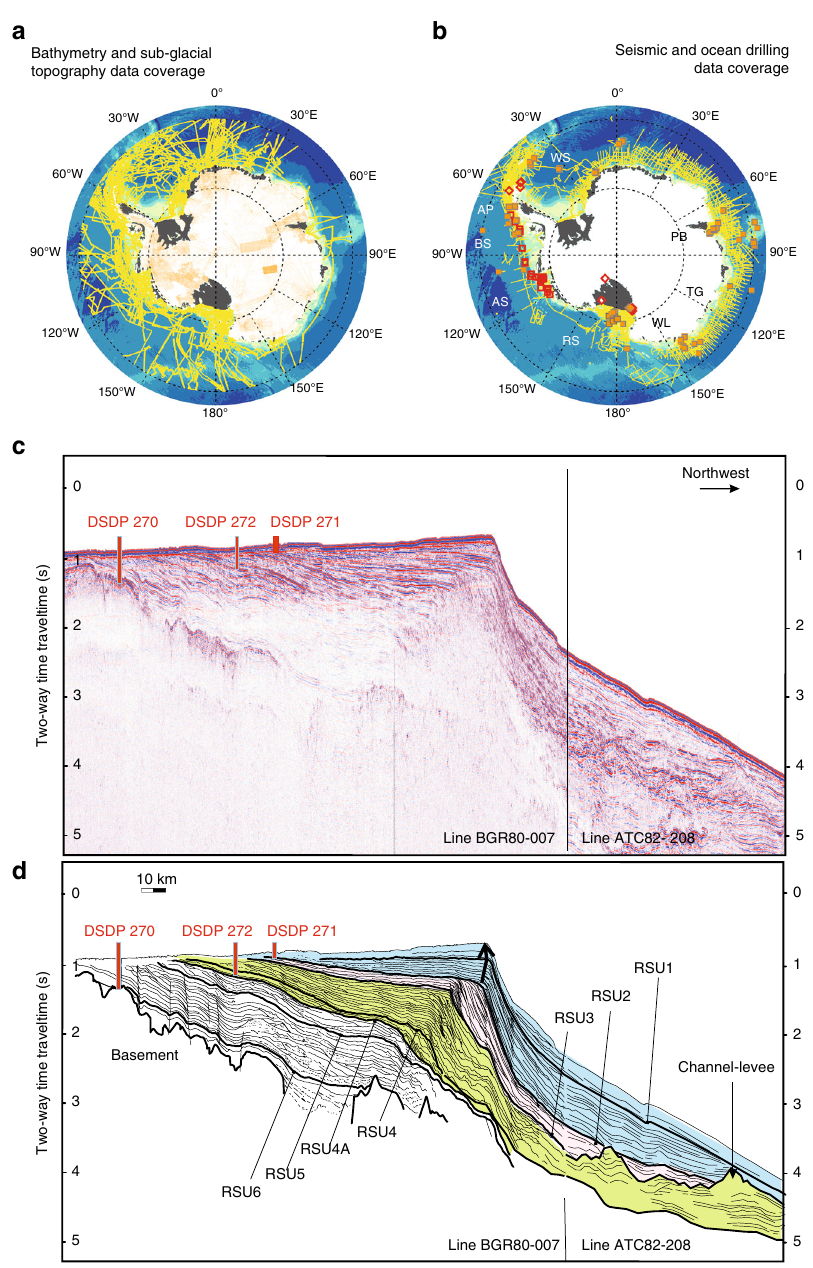
Fig. 3 Present and past knowledge of continental margins morphology. a Bathymetric (yellow) and subglacial topography (orange) data coverage used to reconstruct the BEDMAP2 subglacial topographic dataset 34 including the bathymetry around the margins from the IBCSO dataset 56 (here, multibeam coverage only). b Seismic data coverage (yellow, Antarctic Seismic Data Library System, https://sdls.ogs.trieste.it) from Antarctic Peninsula (AP), Amundsen Sea (AS), Bellingshausen Sea (BS), Ross Sea (RS), Weddell Sea (WS), Wilkes Land (WL), Prydz Bay (PB) and Sabrina Coast-Totten Glacier (TG) continental margins. Existing (yellow squares) or short-term scheduled (red) Ocean Drilling Program/International Ocean Discrovery Program drilling sites (https://iodp.tamu.edu/scienceops/maps.html) used to constrain and restore past continental margins morphology. White or gray areas indicate little or no data coverage. c Multichannel seismic pro fi les BRG80-007 and ATC82-208 in the Ross Sea with existing deep drill site locations (projected) from Deep Sea Drilling Program Leg 28 116 . d Line drawing 52 showing the horizons from the Oligocene-early Miocene Ross Sea Unconformity RSU6 to the Pleistocene RSU1 across the eastern Ross Sea. Progradation of the continental shelf margin occurred from RSU4A to RSU3 (early-late Miocene, 19-10 Ma 51,52 ), along with channel-levee complexes formation in the deeper areas (green shade). During the next phase between RSU3 and RSU2 (late Miocene- early Pliocene, 10 – 4 Ma 51,52 ), trough-mouth fans formed on the continental slope and sedimentation rates gradually decreased in the continental shelf and rise (pink shade). The change from a prograding to aggrading continental shelf edge (indicated by the arrows) is observed after RSU2 from early to mid- Pliocene (4 – 3.7 Ma), when the shelf pro fi le became landward